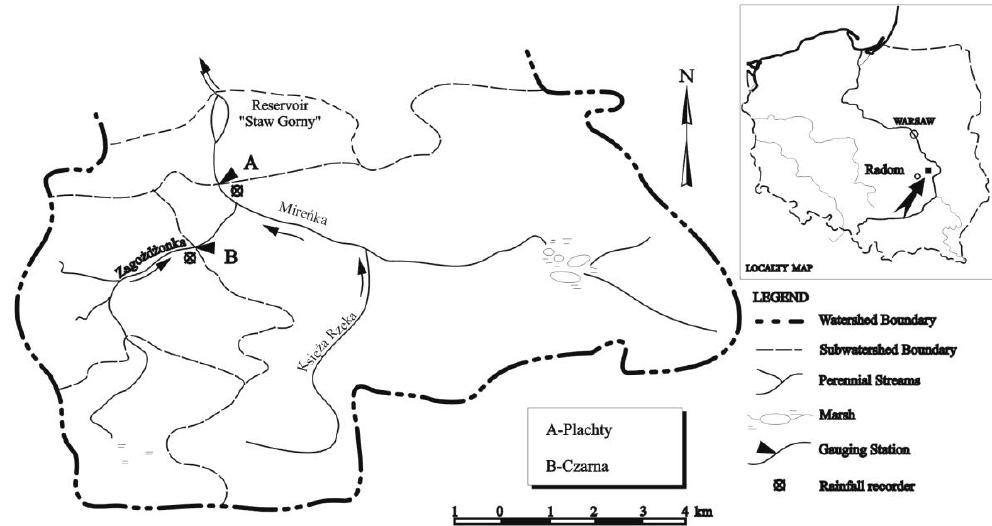
Figure 1. Locality map of the